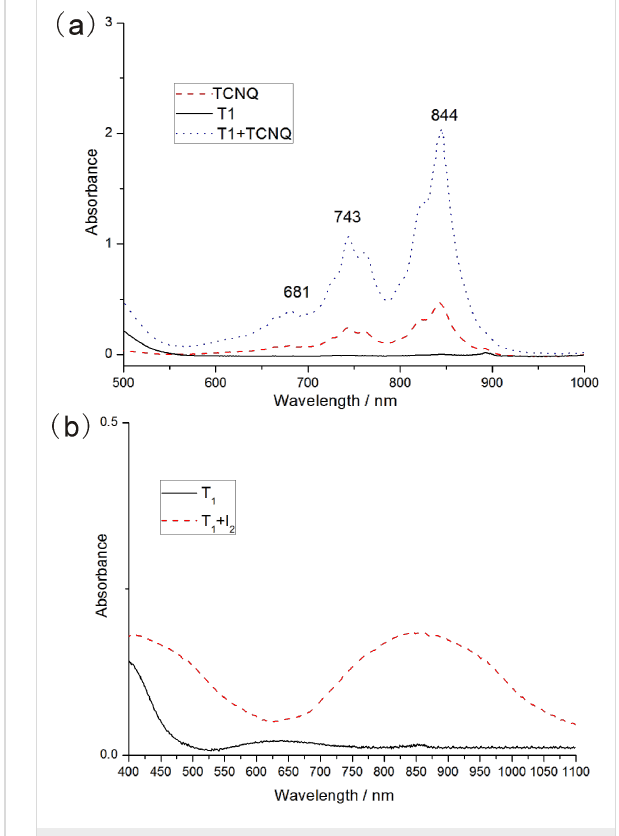
Figure 5: (a) UV–vis spectra of T 1 solutions TCNQ and T 1 /TCNQ in ethyl acetate (1 × 10 − 3 M). (b) UV–vis spectra of T 1 before and after iodine doping for 30